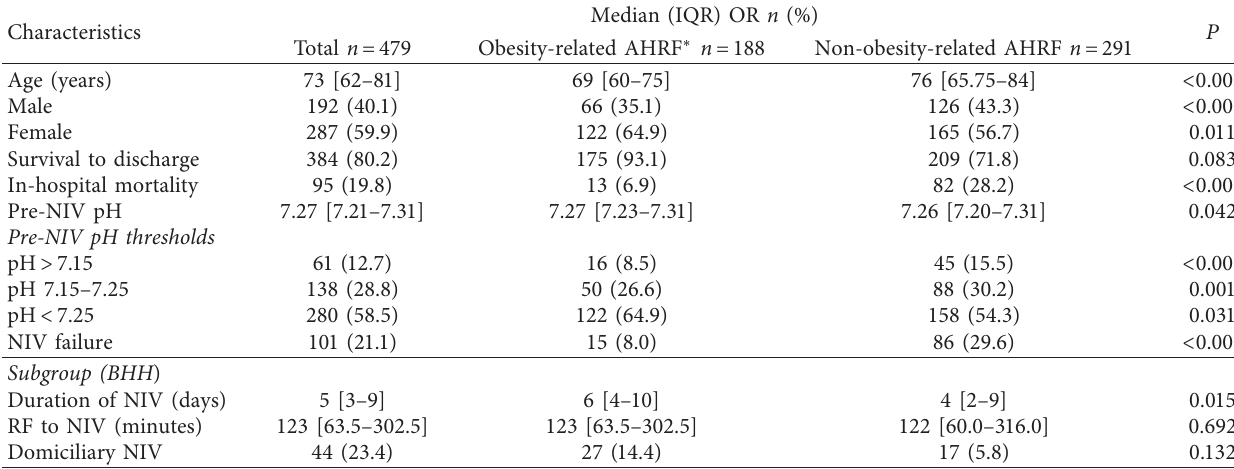
Table 1: Participant baseline characteristics.